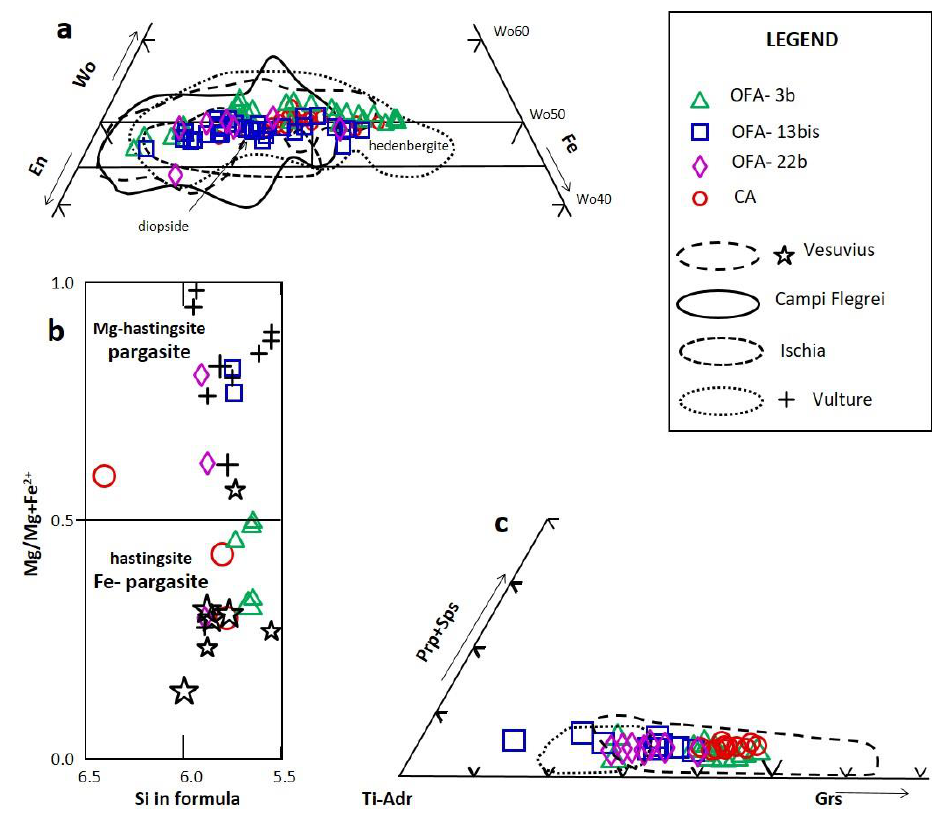
Figure 6. Composition of volcanic heavy minerals in the Ofanto River and Cilento sands. ( a ): Pyroxene composition. Compositional fields of clinopyroxene from Vulture (data from [18–20,39–41]), Vesu- vius (data selected from [37,42]), Ischia (data from [43]) and Campi Flegrei (data from [44–53]) are shown for comparison; ( b ) amphibole (after [38]). Data of amphiboles from Vulture (from [18,20,40]) and Vesuvius (from [42]) are also shown for comparison. Smaller symbols indicate crystals with Al VI < Fe 3+ (Mg-hastingsite and hastingsite), bigger symbols indicate crystals with Al VI < Fe 3+ (parg- asite and Fe-pargasite); ( c ) garnet. Compositional fields of garnet from Vulture (data from [18,20,54]) and Vesuvius (data from [42,55,56]) are also shown for